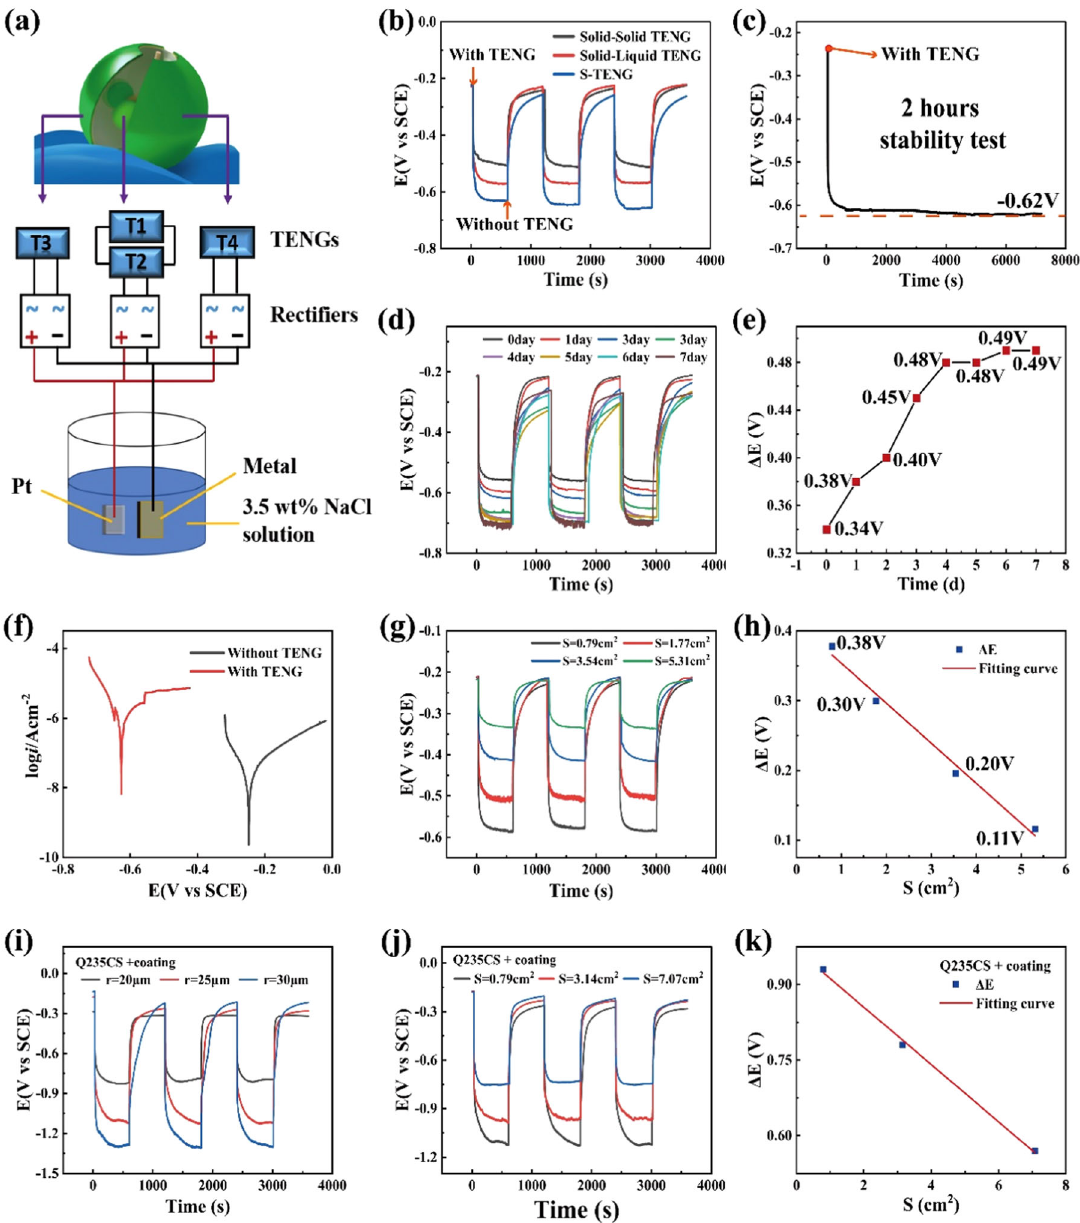
Fig. 4 The cathodic protection performance of S-TENG. a Schematic arrangement of the S-TENG cathodic protection of metal in 3.5 wt% NaCl solution. b Potential changes of a 304SS electrode coupled with and without solid-solid TENG, solid-liquid TENG and S-TENG respectively. c Stability test of the S-TENG. d Potential changes of a 304SS electrode coupled with and without S-TENG at different immersion time. e Potential drop value of 304SS at different immersion time. f Tafel curves of 304SS with and without S-TENG. g Potential changes of 304SS electrodes with different areas coupled with and without S-TENG. h Potential drop value of 304SS with different areas and its fi tting curve. i Potential change of a Q235CS electrode coupled with and without S-TENG at different the coating thickness. j Potential changes of Q235CS electrodes with different areas coupled with and without S-TENG. k Potential drop value of Q235 with different areas and its fi tting